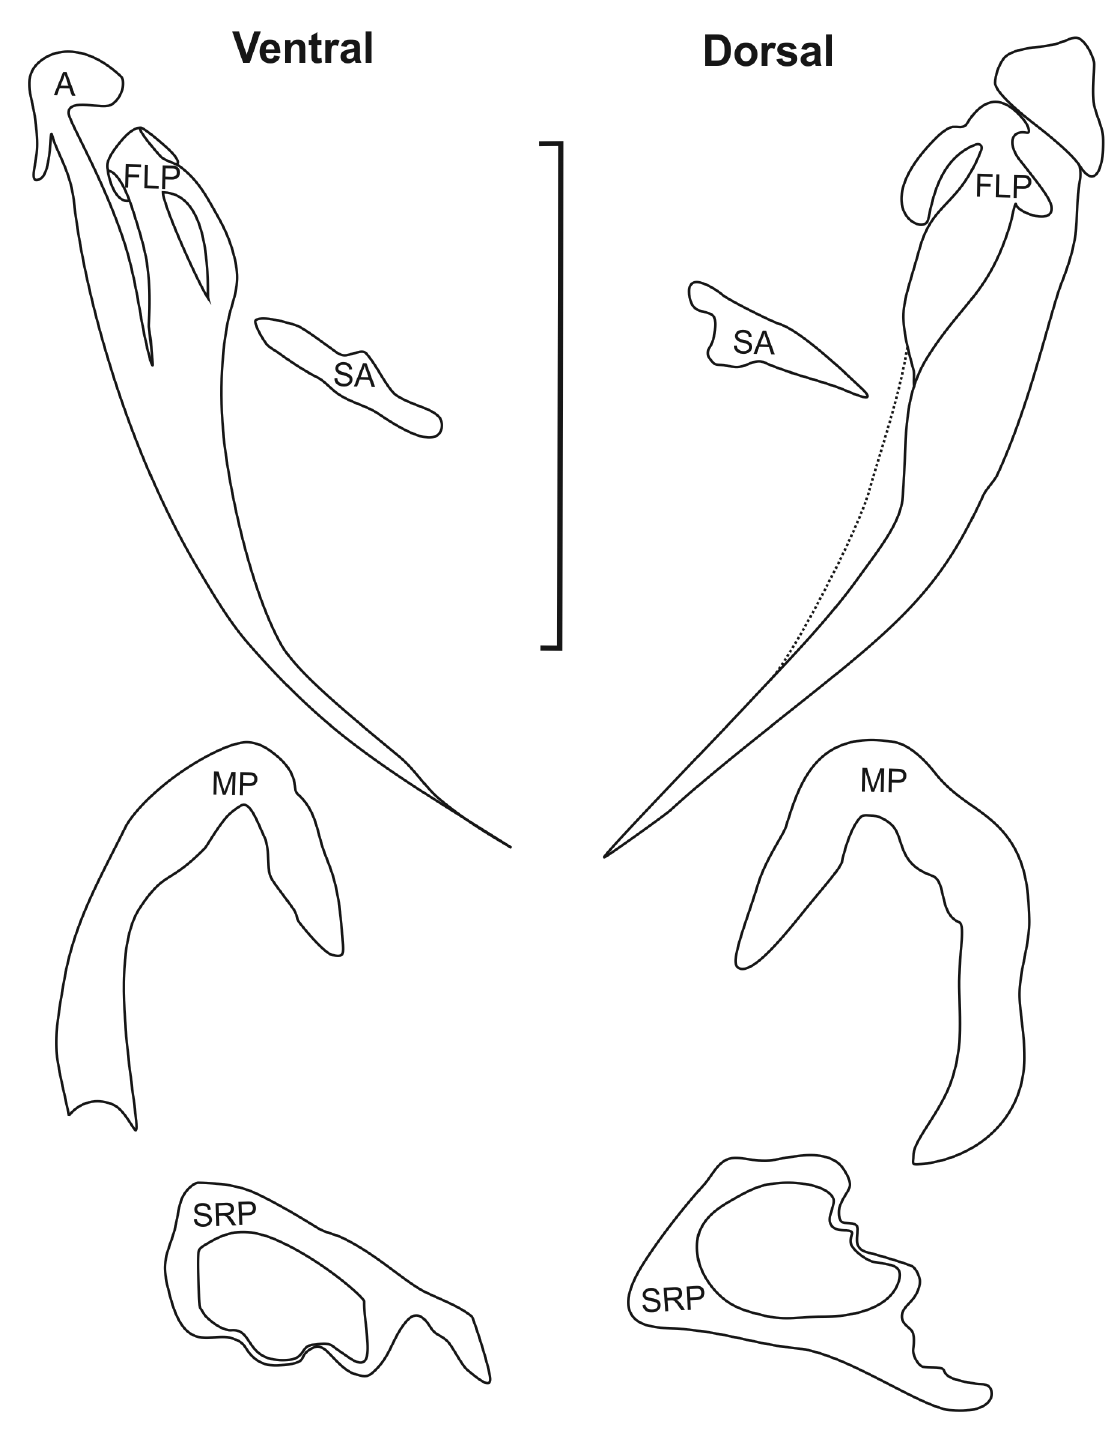
Fig. 5. Sclerites of the internal sac of Canthon (G.) smaragdulus subviridis Schmidt, 1922 stat. rev. Abbreviations: see Material and methods. Scale bar: